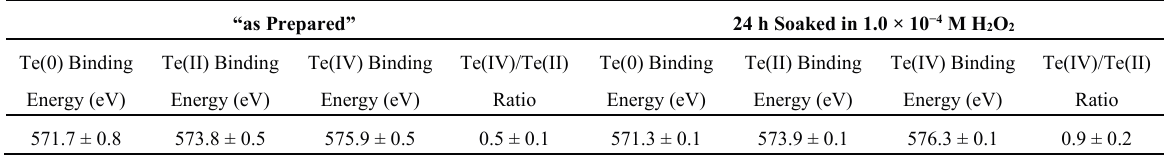
Table 3. The position and ratios of Te(II) and Te(IV) calculated for samples “as prepared” and after submersion in 1.0 × 10 − 4 M H 2 O 2 for 24 h. The position and ratio values are the mean of five spectra recorded for each sample ± 1 SD. The peak positions were referenced by setting a C 1s peak to 284.5 eV.